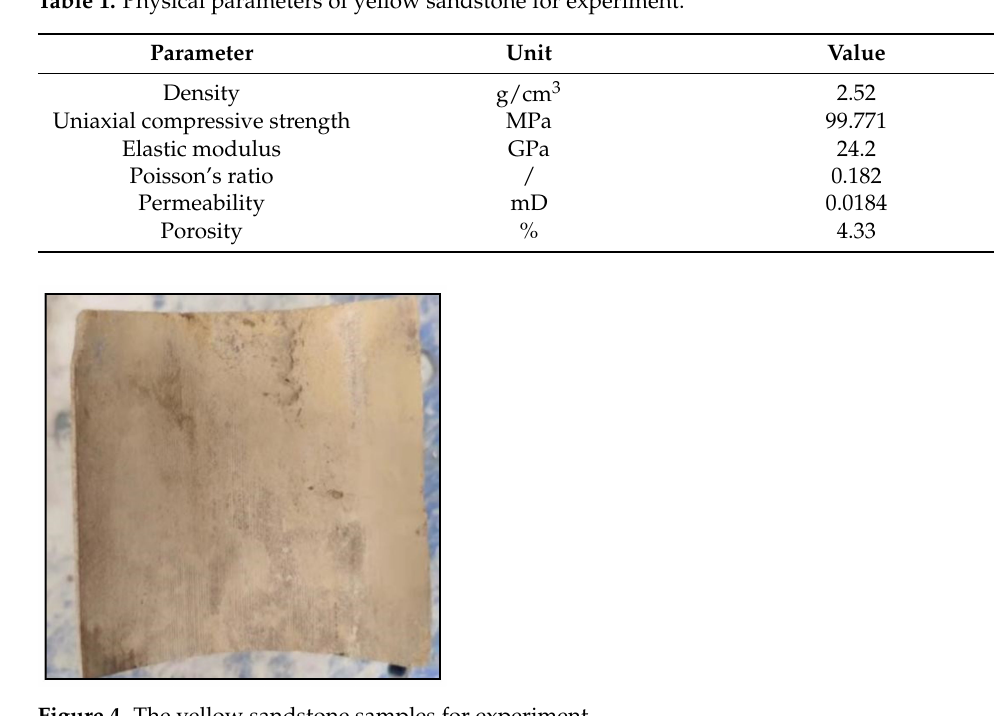
Figure 4. The yellow sandstone samples for